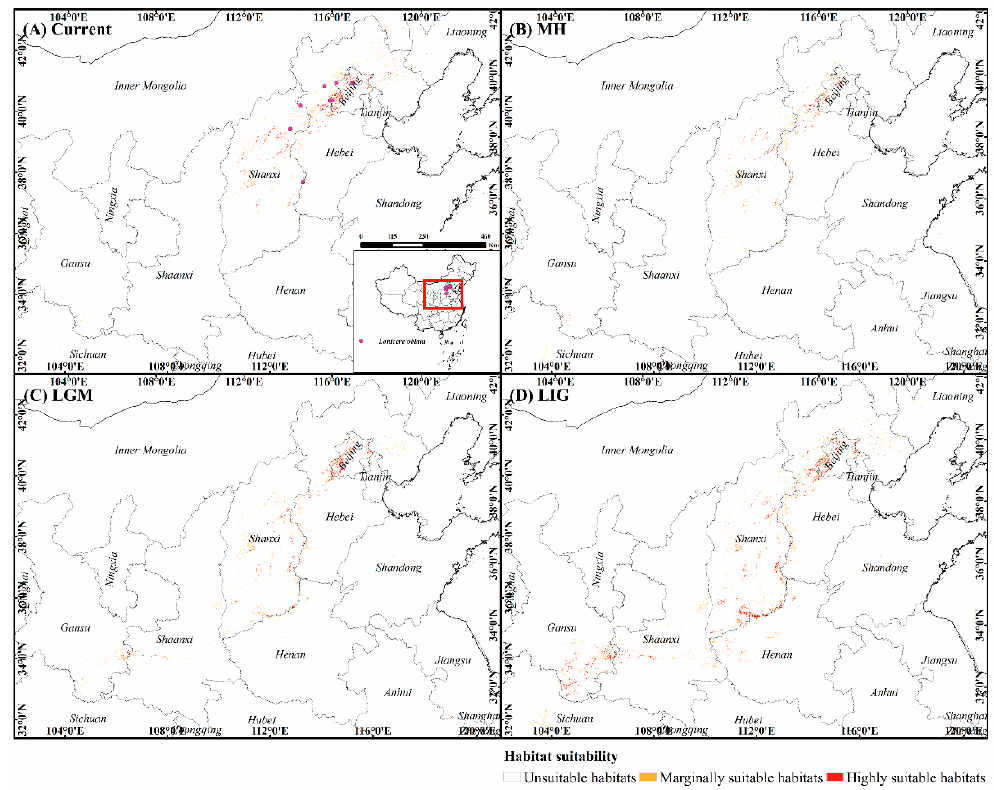
Figure 3. Comprehensive habitat suitability of Lonicera oblata under past and current periods. ( A ) Current; ( B ) the middle Holocene; ( C ) the Last Glacial Maximum; ( D ) the Last Interglacial.